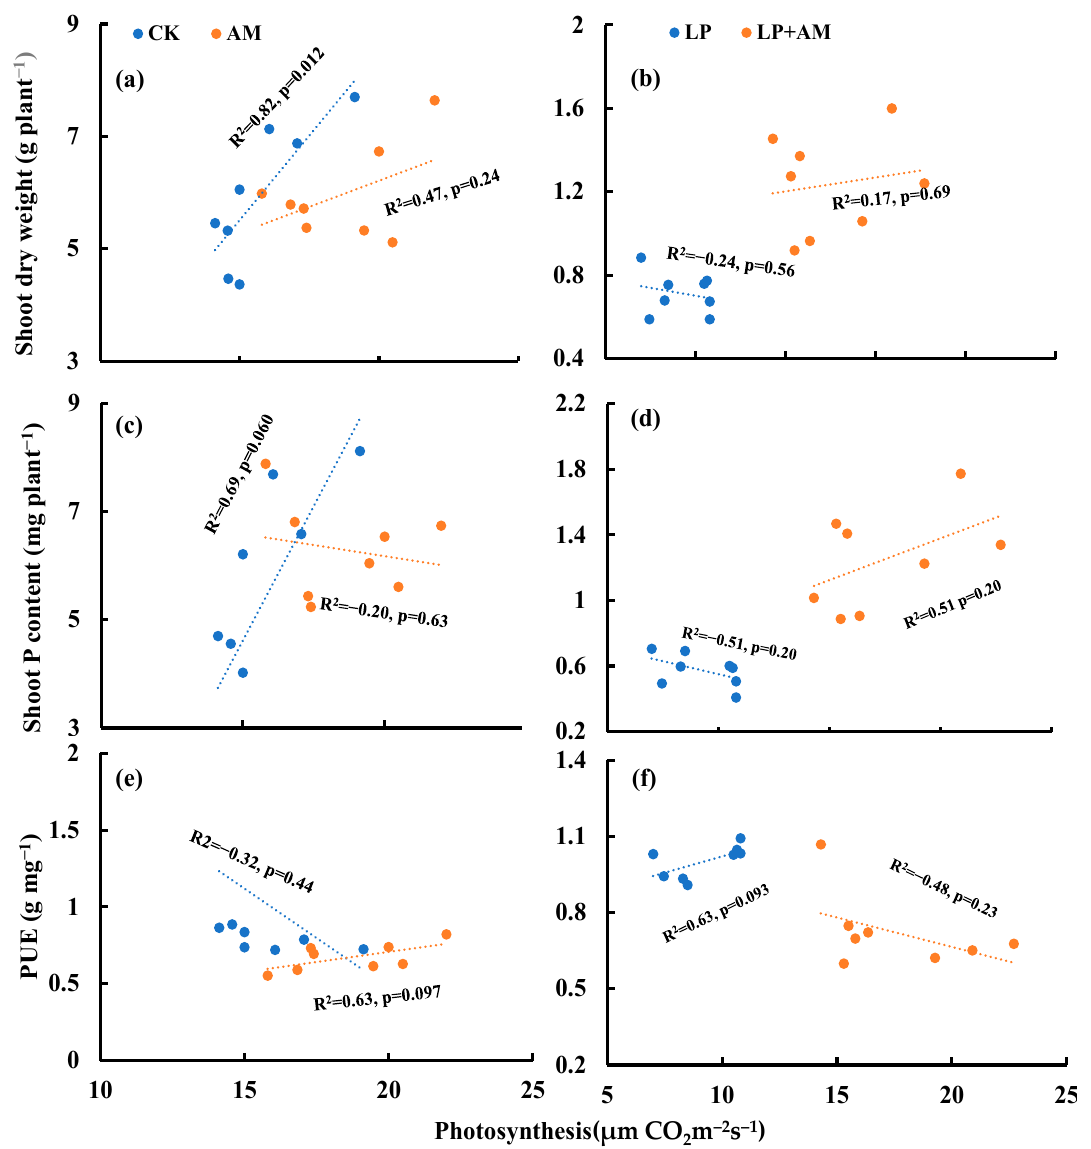
Figure 6. The relationship between photosynthesis and shoot dry weight ( a , b ), shoot P content ( c , d ), and PUE ( e , f ) under four treatments. Note: Correlation coefficient of each trait from Pearson correlation analysis, data from each maize plant. PUE, phosphorus utilization efficiency.